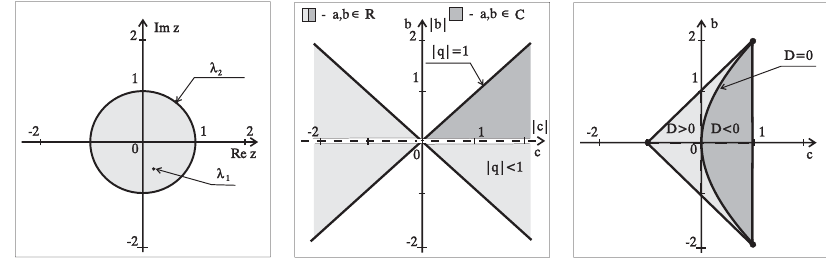
Figure(cid:3)(cid:1)Hurwitz(cid:19)scrite(cid:14)